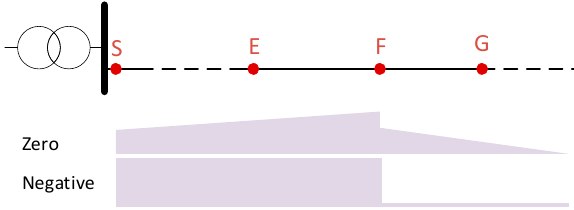
Figure 3. Behavior of zero and negative sequence currents on the faulted feeder in an isolated neutral